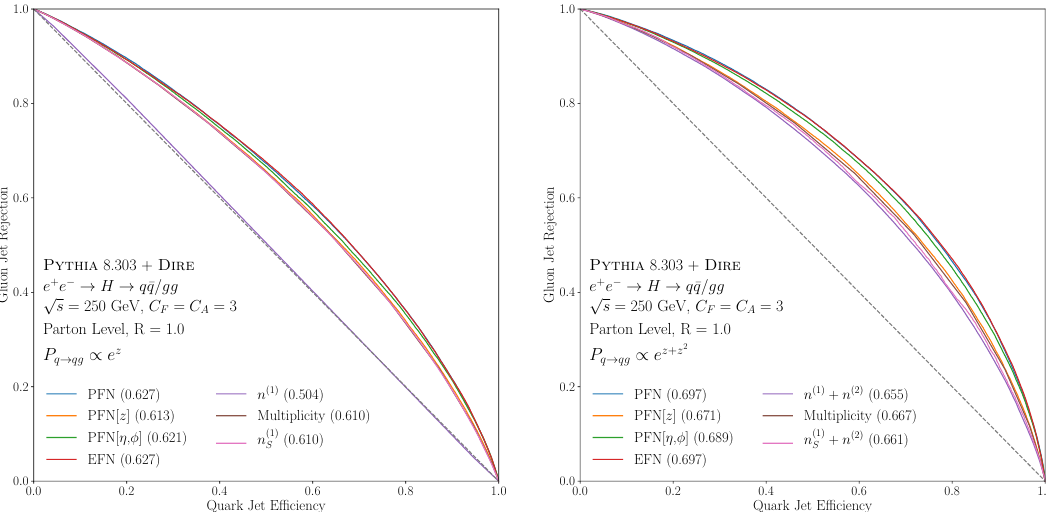
Figure 4 . ROC curves and AUCs for the settings P q → qg ∝ exp( z ) (left) and P q → qg ∝ exp( z + z 2 ) (right). In each case the likelihood ratio contains the trivial term n (1) , and ROCs using alternative formulation n (1) of eq. (4.4) are shown in an additional S